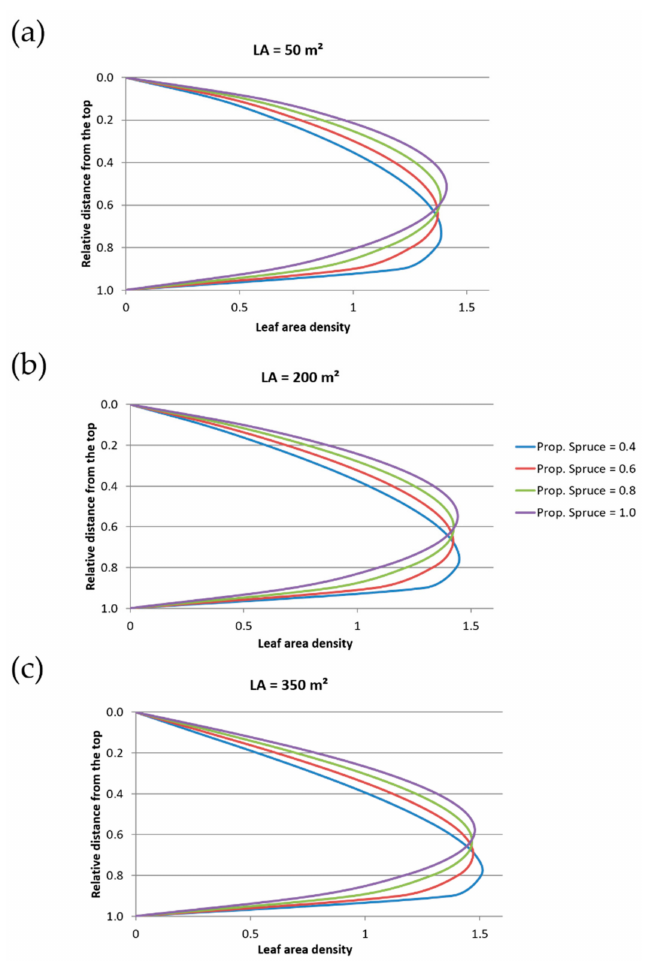
Figure 6. The predicted vertical distribution of the leaf area of spruce, obtained by a linear mixed e ff ect model (Equation (11)) with parameter estimates from Table 5, depending on thespruce proportion of the stand (Prop. Spruce) for di ff erent individual tree leaf areas (LA). ( a ): LA = 50 m 2 , ( b ): LA = 200 m 2 and ( c ): LA = 350 m 2